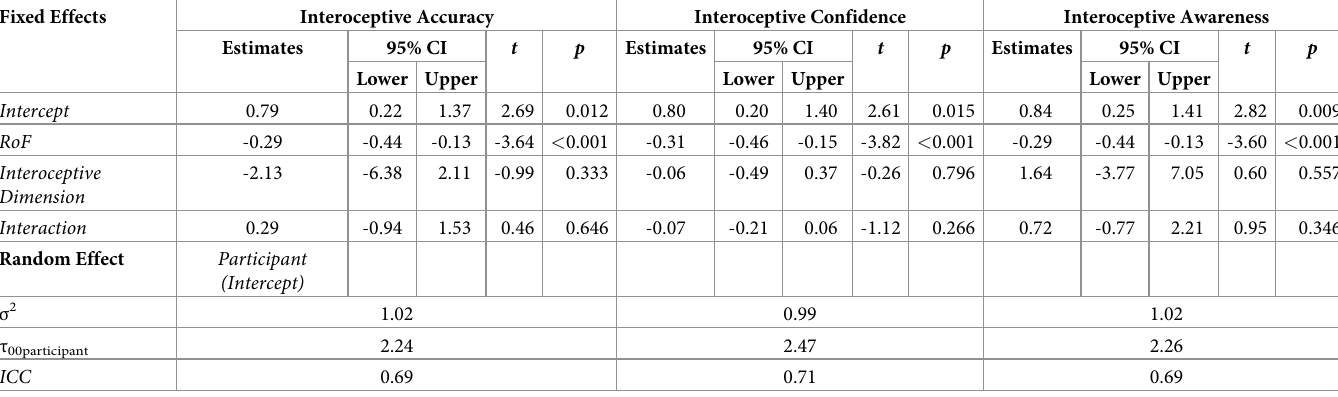
Table 3. Moderating effect of the dimensions of interoception on the relationship between perceived fatigue and the affective valence. Fixed